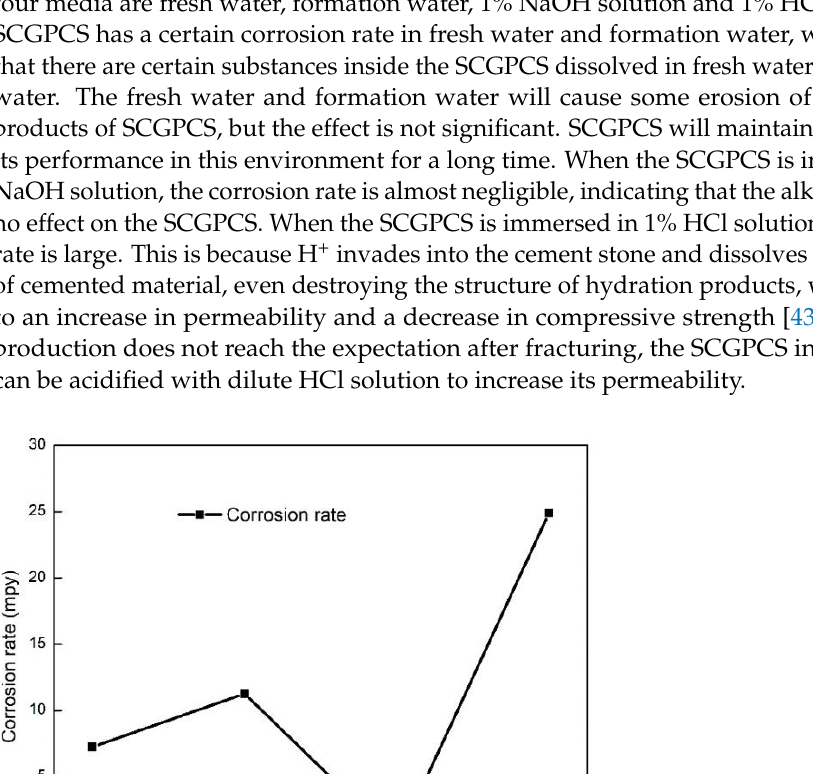
Figure 17. Graphene – foam – cement slurry system thickening curve.